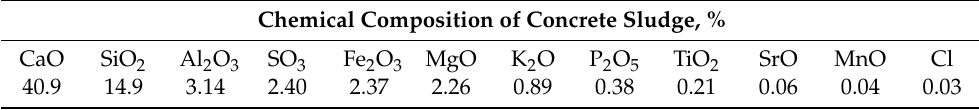
Table 1. Chemical composition of dry concrete sludge.